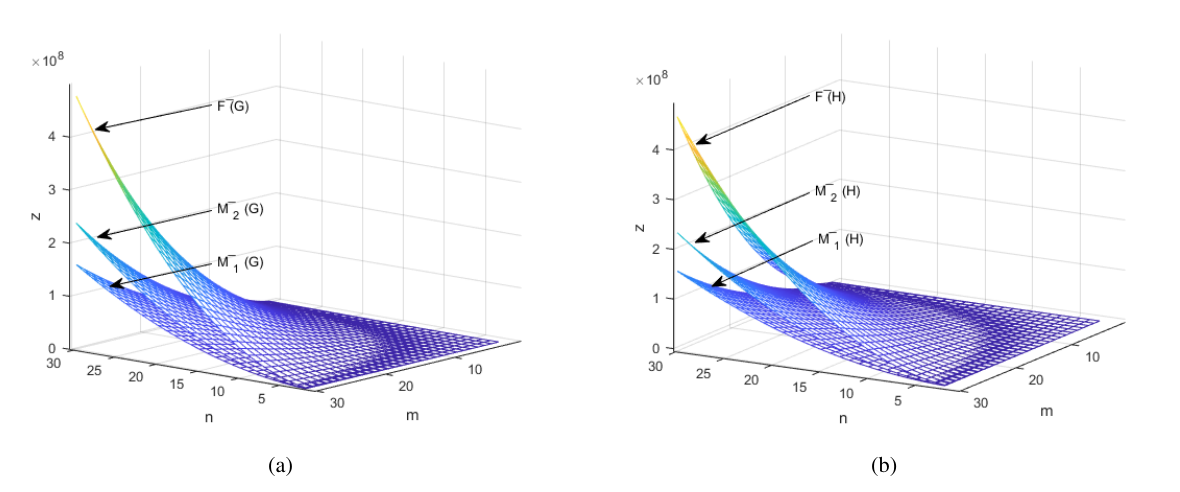
Fig. 5 Comparative model for different coindices of TUC 4 C 8 ( S )[ m , n ] (a) nanotubes and (b)